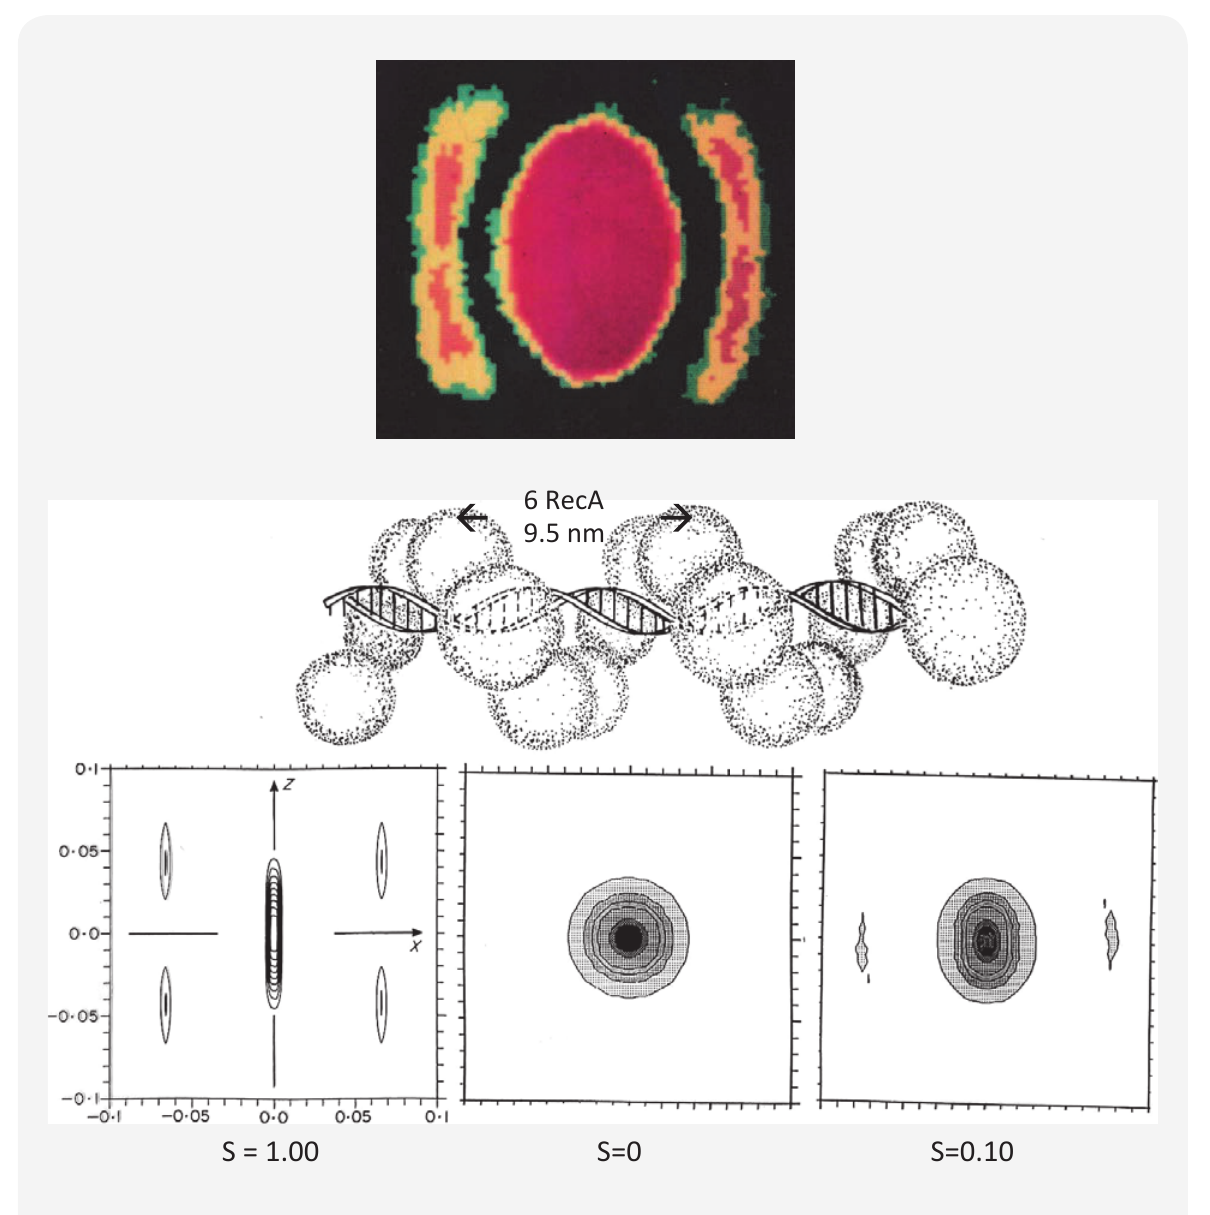
Figure 4. Structure model of RecA-DNA fi ber from small-angle neutron scattering (SANS) and linear dichroism (LD) measurements of fl ow-aligned solu- tions. Experimental SANS pattern (color, top) shows the helical cross corresponding to an arrangement of RecA proteins as shown in model. Below model patterns for different values of fl ow orientation parameters (S). Figure adapted from results in Refs. 20–25, 27,